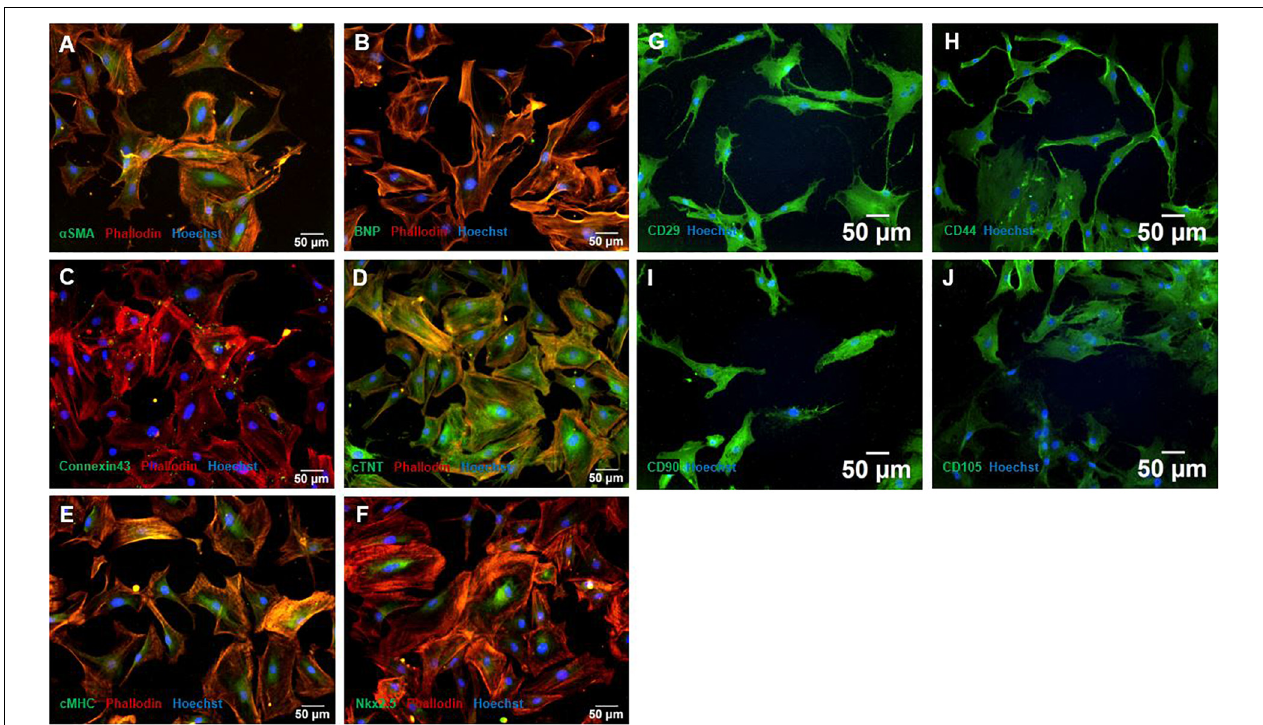
FIGURE 2 | Characterization with immunofluorescence staining of MSC and CMC. CMC showed typical cardiac lineage marker expression of α SMA (A) , BNP (B) , Connexin 43 (C) , cTNT (D) , cMHC (E) , and Nkx2.5 (F) . MSC showed the expression of characteristic stem cell markers CD29 (G) , CD44 (H) , CD90 (I) , and CD105 (J) . Cells were counterstained with Hoechst. MSC – Mesenchymal stem cells. CMC – cardiomyocytes. cTNT – Cardiac Troponin T. cMHC - Cardiac Heavy Chain Myosin. α SMA - α